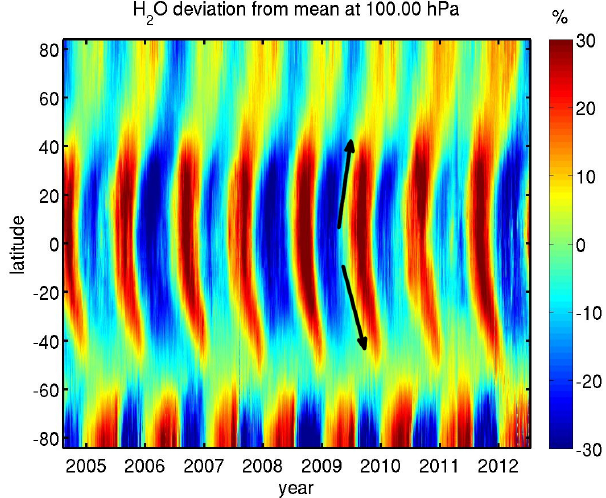
Fig. 3. Relative deviation from the average zonal mean H 2 O as a function of time and latitude at 100 hPa. Red colors show above average concentrations, blue shows below average values. The visible seasonal cycle with an amplitude of about 30 % is transported from the tropics towards the poles by the meridional BDC as indicated by the arrows and can be identified along the slant lines of same colors. The slope is steeper towards the NH which is due to a stronger and faster BDC.